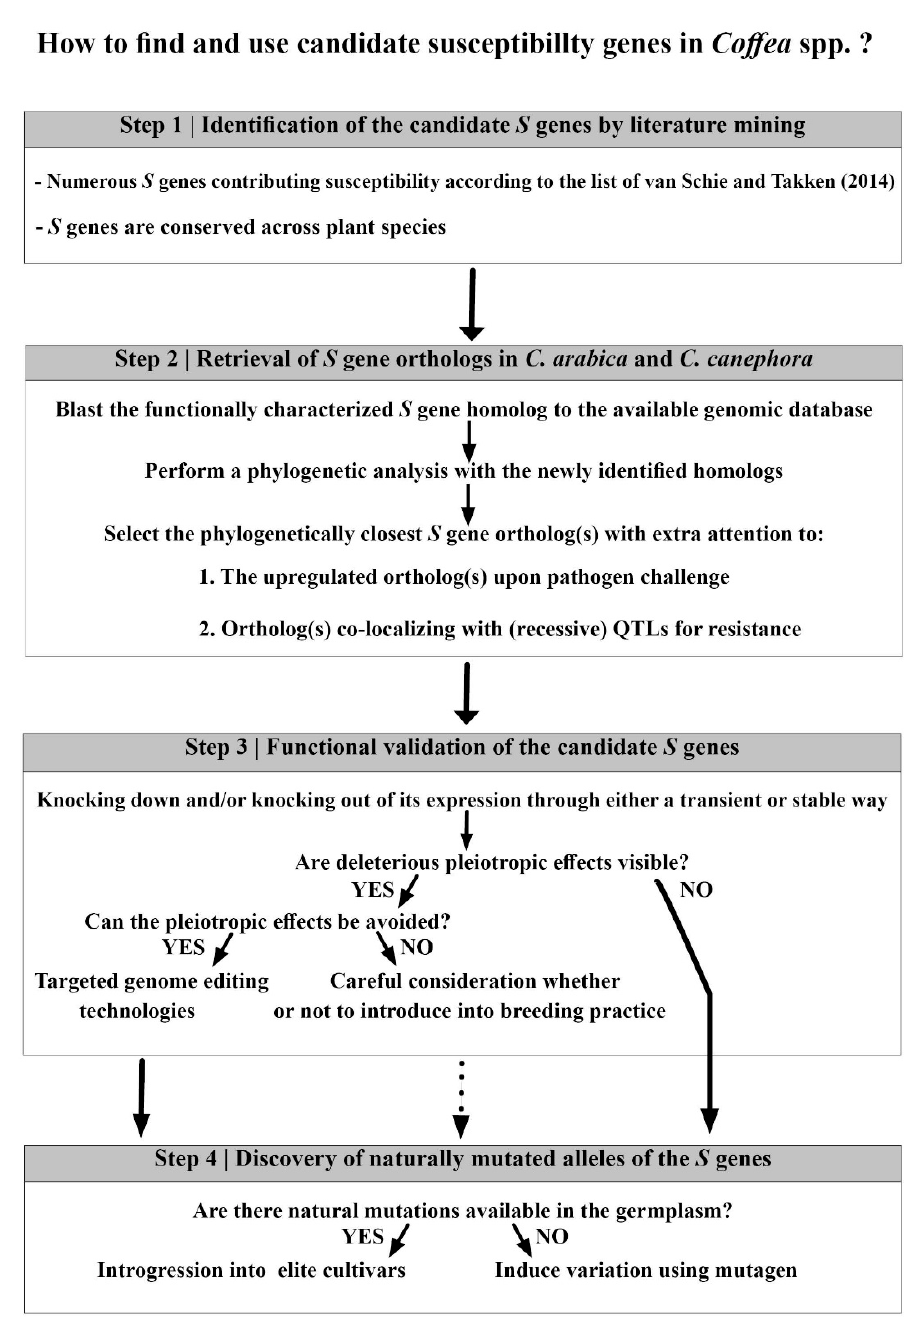
Figure 2. Guidelines on how to find and use susceptibility genes in Coffea spp.